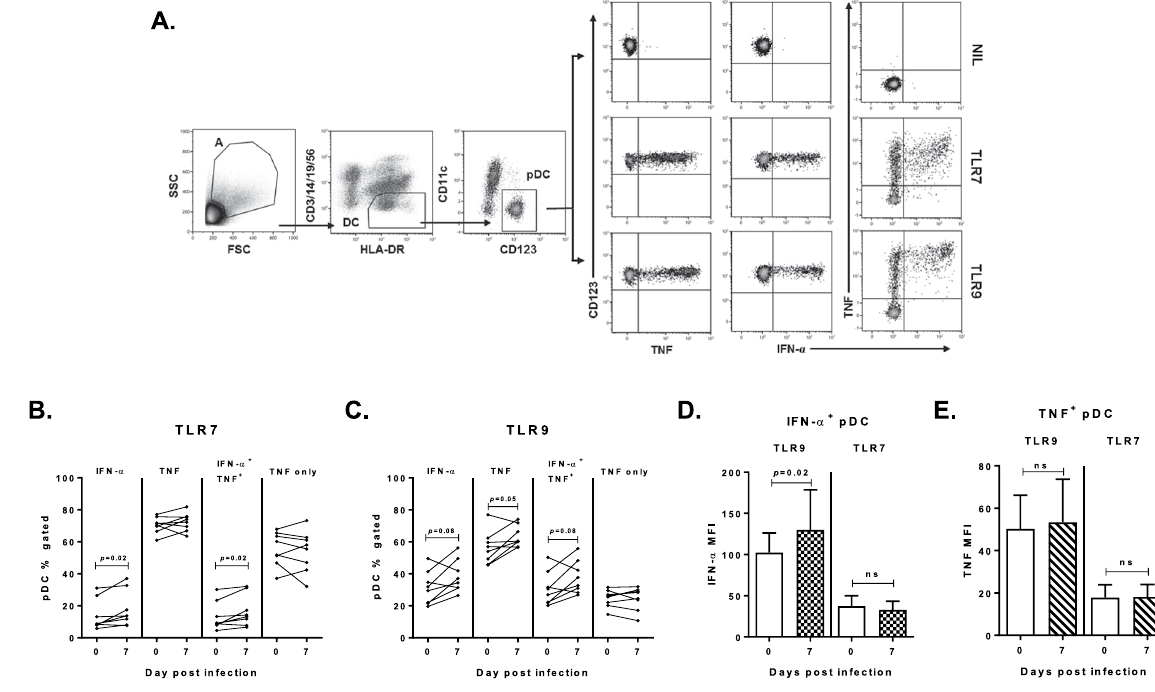
Figure 4. pDC cytokine responses to TLR stimulation. ( A ) Representative staining of circulating pDC in PBMC evaluated for intracellular cytokines. pDC were identified as lineage (CD14, CD3, CD19 and CD56) − , HLA-DR + , CD11c − and CD123 + . Intracellular cytokine production by ex vivo pDC on day 0 (IFN- α and TNF) in three conditions: no stimulation (top panel), TLR7 stimulation (middle panel) and TLR9 stimulation (bottom panel). ( B ) IFN- α and TNF produced by pDC on day 0 and day 7 after TLR7 stimulation, n = 8. ( C ) IFN- α and TNF produced by pDC on day 0 and day 7 after TLR9 stimulation, n = 8. ( D ) IFN- α MFI of IFN- α producing pDC after TLR7 or TLR9 stimulation, n = 8. ( E ) TNF MFI of TNF producing pDC after TLR7 or TLR9 stimulation, n = 8. Data are represented as median and interquartile range. The Wilcoxon matched-paired test was used for comparison between day 0 and day 7. Abbreviations: FSC, forward scatter SSC, side scatter, MFI, median fluorescence